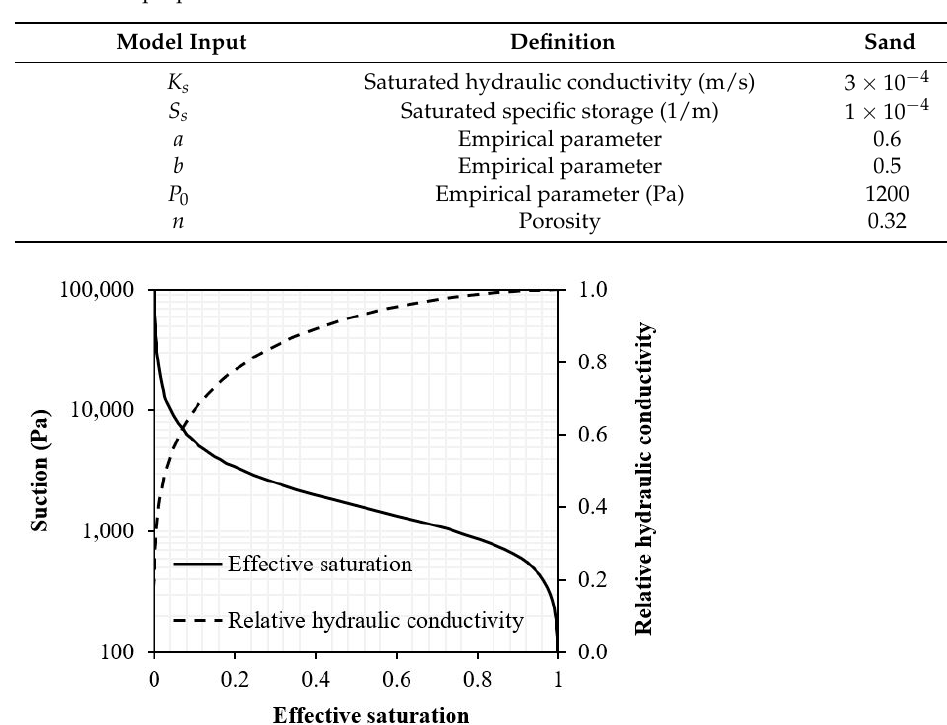
Figure 3. SWCC and relative hydraulic conductivity